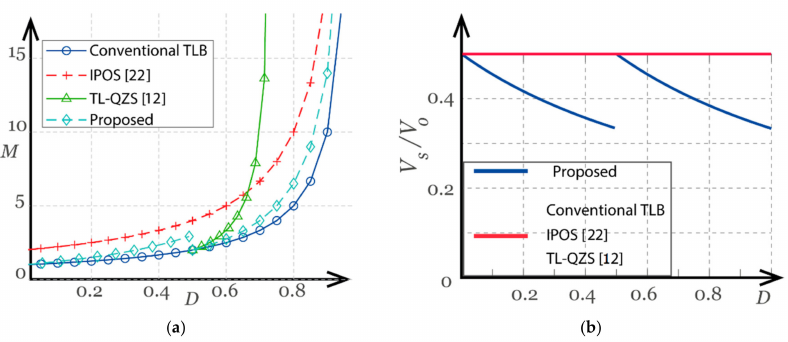
Figure 6. Comparison between the proposed converter and other step-up converters. ( a ) Gain vs. duty cycle. ( b ) Voltage stress vs. duty